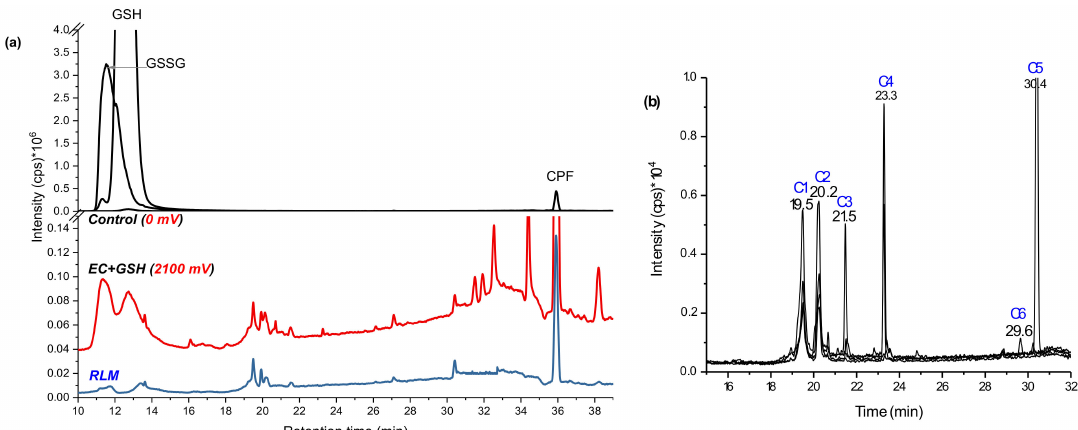
Figure 2. Total ion chromatogram (TIC) of GSH and CPF oxidative products in the control (black), in 2100 mV DC potential (red), and in RLM incubates (blue) ( a ), and extracted ion chromatogram (EIC) of bioconjugates at 2100 mV DC potential ( b ) using BDD WE recorded by LC-MS/MS on (+)